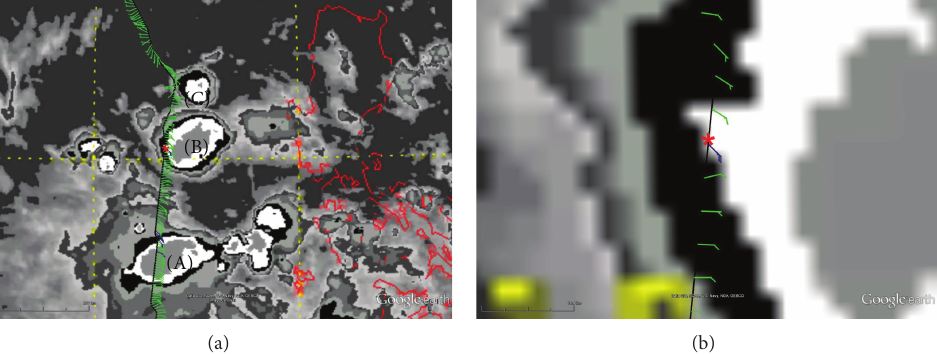
Figure 5: Flight path (from bottom to top) and wind barbs recorded on the aircraft as overlaid on the satellite picture of MTSAT. The asterisk shows the location of the severe turbulence event, (b) is a zoom-in of (a) around the turbulence event location.